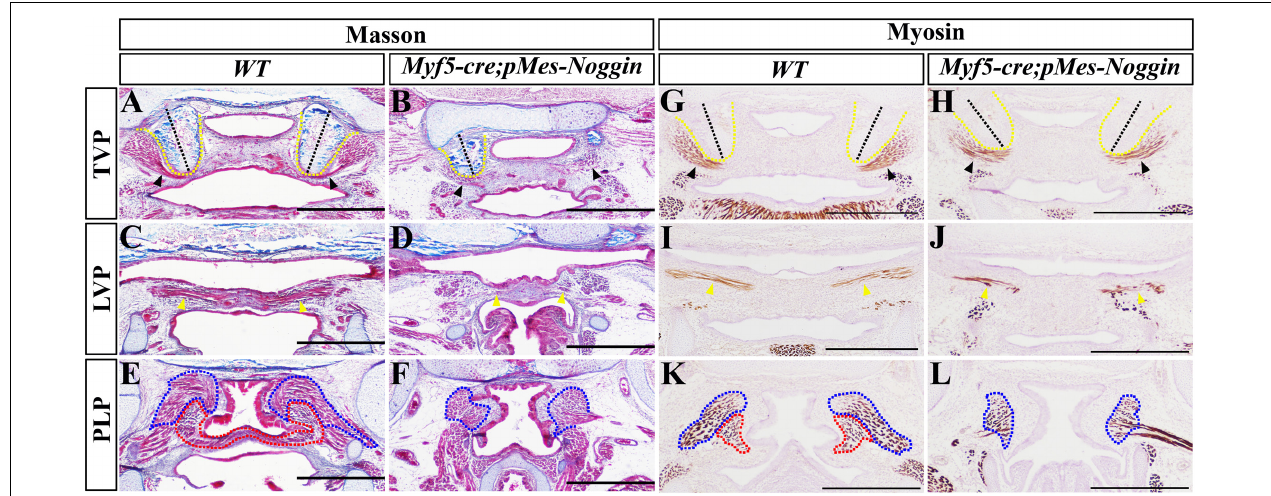
FIGURE 5 | The fusion and muscle morphology in Myf5-cre;pMes-Noggin soft palate. (A–F) Masson staining of the E17.5 WT and Myf5-cre;pMes-Noggin soft palates. The TVP (A) , LVP (C) , and PLP (E) levels of WT soft palate were compared with the Myf5-cre;pMes-Noggin TVP (B) , LVP (D), and PLP (F) levels. (G–L) The immunostaining of myosin of the E16.5 WT and Myf5-cre;pMes-Noggin soft palates. The TVP (G) , LVP (I) , and PLP (K) of WT soft palate were compared with the TVP (H) , LVP (J) , and PLP (L) of the Myf5-cre;pMes-Noggin soft palate. The black dashed lines indicate the orientation of HPPs; the black arrowheads delineate TVPs; the yellow arrowheads point to LVPs; the blue dotted lines circle SPCs; the red dotted lines mark PLPs. Scale bars are 200 µ m. TVP, tensor veli palatini; LVP, levator veli palatini; PLP, palatopharyngeus; HPP, hypophosphatasia; SPC, superior pharyngeal